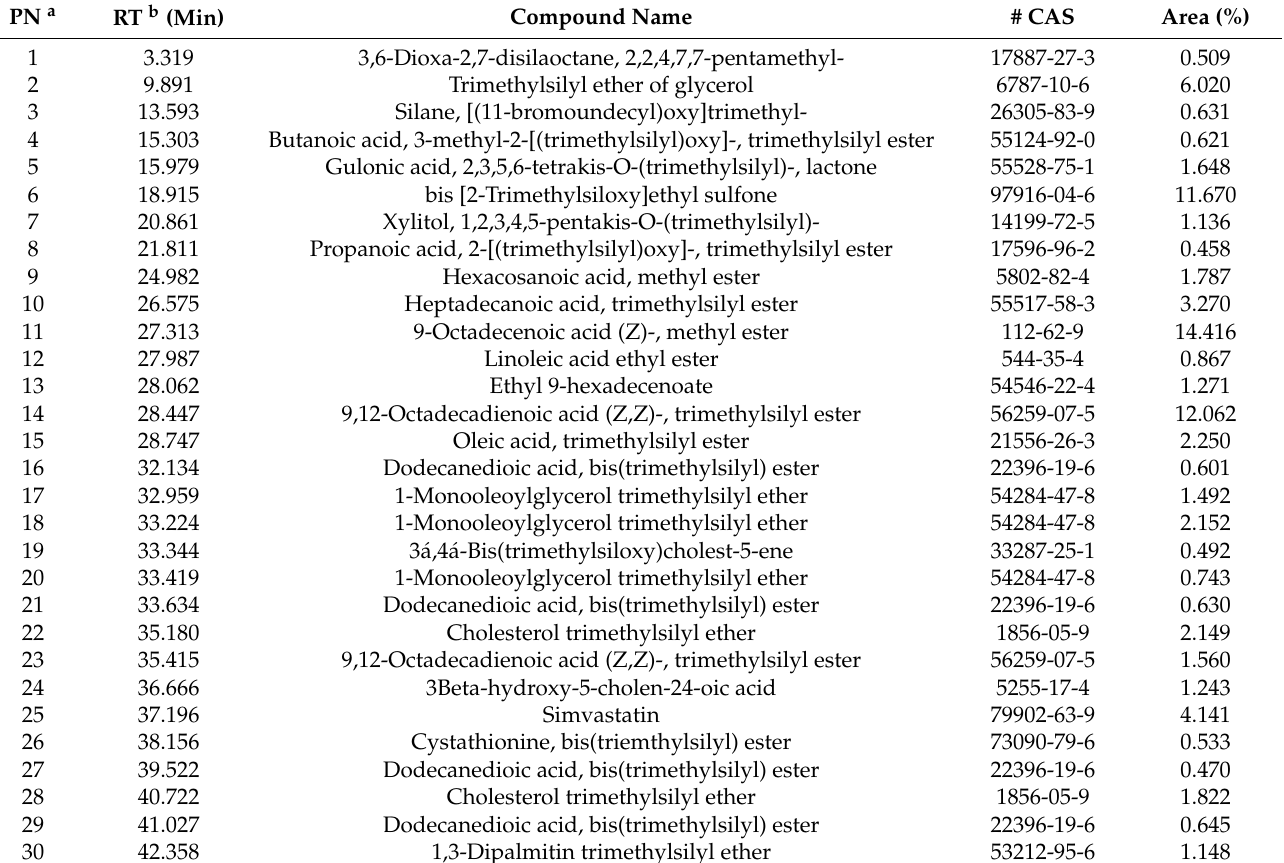
Table 4. Identification of organic compounds from post-fermented oat straw by